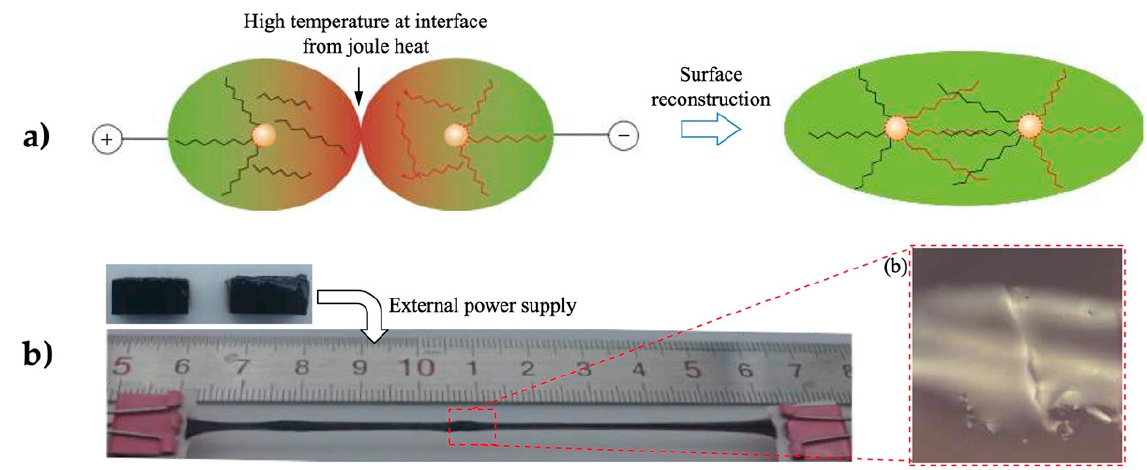
Figure 9. ( a ) Illustration of self-healing process in conductive hydrogel; ( b ) Self-healed material after apply an external current [97]. Reproduced with permission from Wu, B.S; Acta Polymerica Sinica; published by Science Press, 2019.